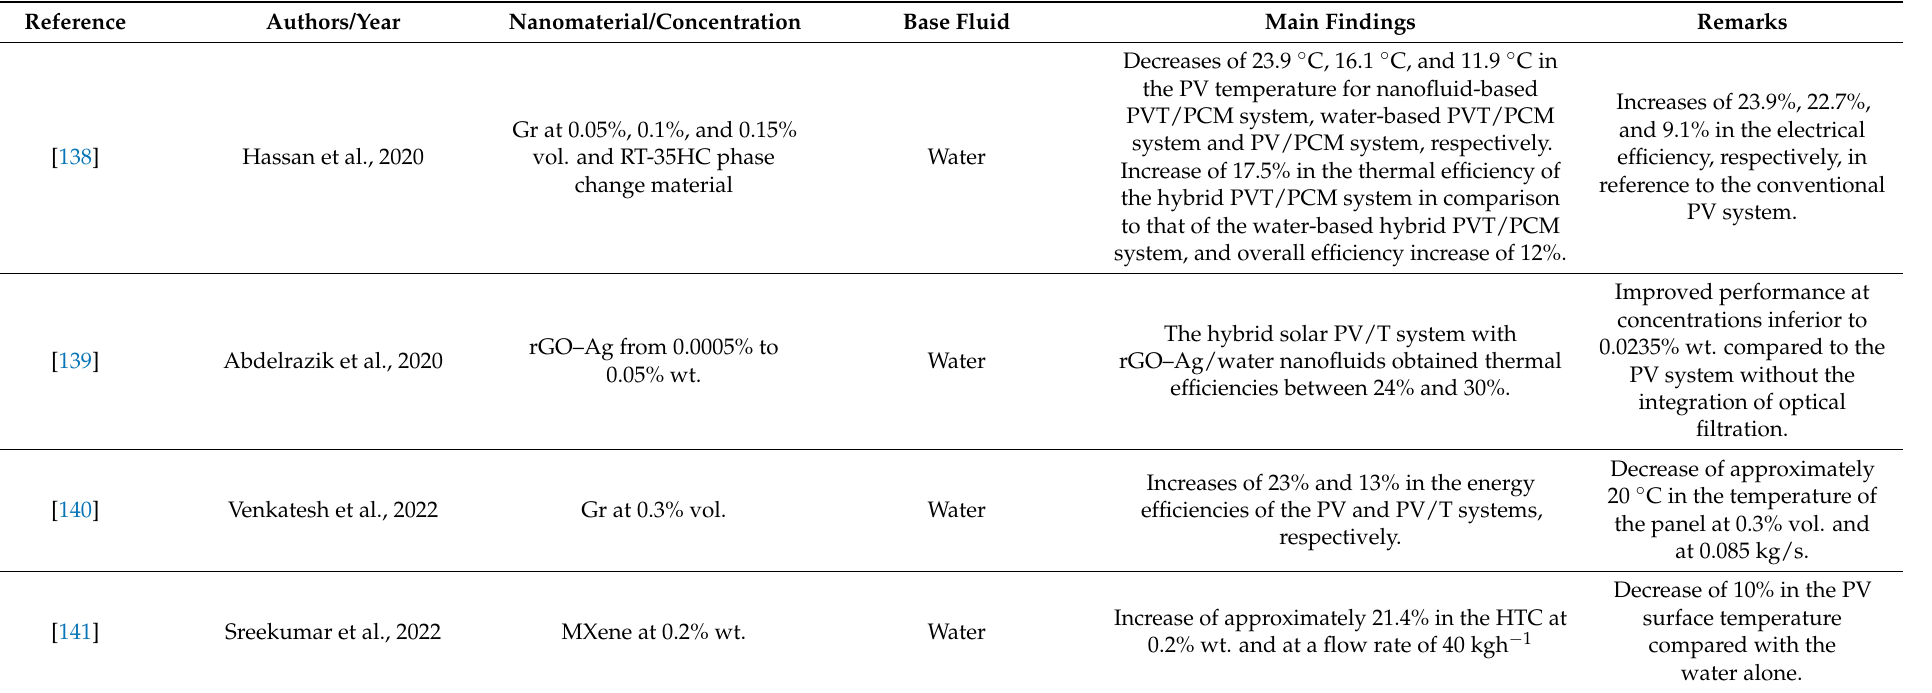
Table 8. Recent works on the use of 2D nanofluids in PV/T